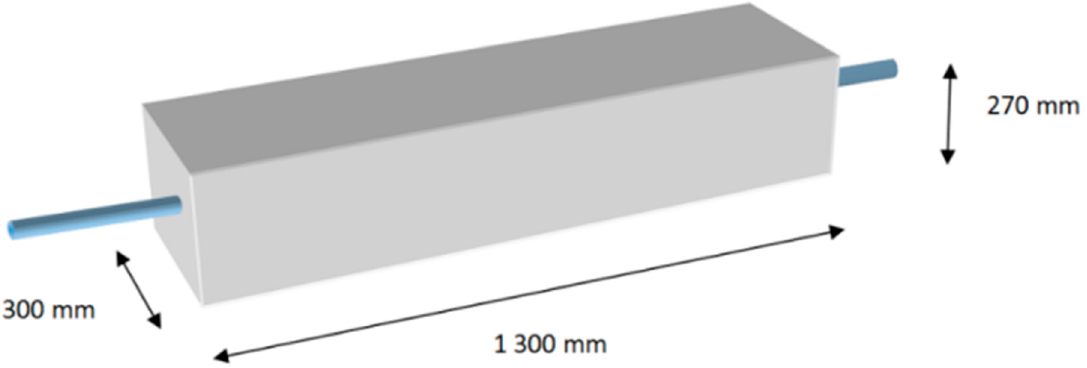
Figure 6. Testing